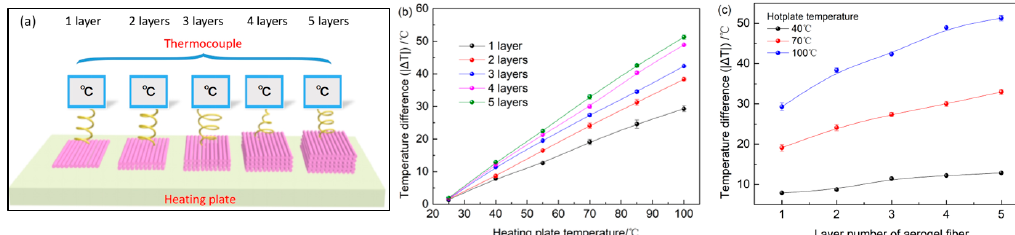
Figure 6. Thermal insulation properties of aerogel fiber mats with different layers. ( a ) Schematic diagram of thermal insulation properties of different layers of aerogel fiber mats. ( b ) The temperature difference (| Δ T |) between the fiber surface and heating plate versus the heating plate temperature for different layers of aerogel fiber mats. ( c ) The temperature difference (| Δ T |) between the fiber surface and heating plate is plotted against layer number of the aerogel fiber mat.